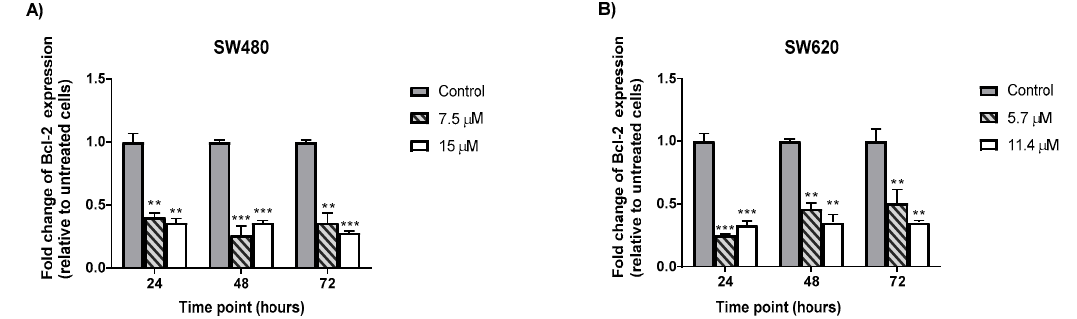
Figure 8. MS13 reduces BCl-2 expression level at di ff erent time points in SW480 ( A ) and SW620 cells ( B ). Experiments were performed in duplicates and compared between two independent experiments. Asterisk indicate statistically significant (* for p ≤ 0.05, ** for p ≤ 0.01, *** for p ≤ 0.001 and **** for p ≤ 0.0001) di ff erences between data sets for each treatment dose. Error bars indicate mean ± SEM.